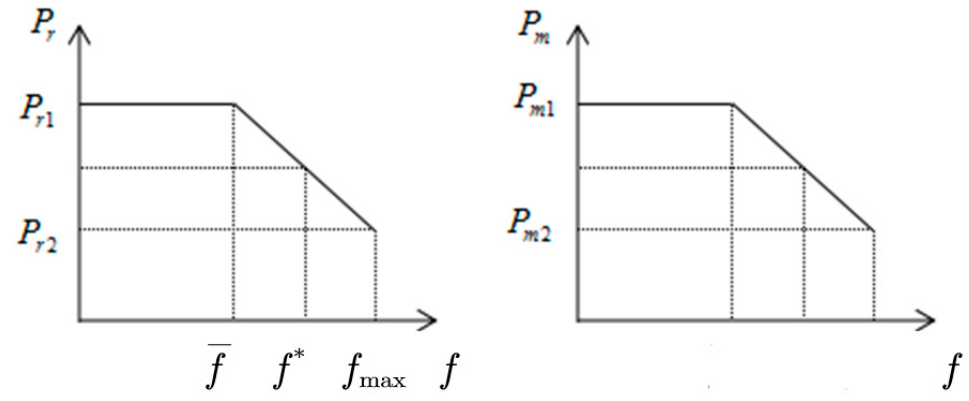
Figure 7. Improved adaptive crossover probability and mutation probability.